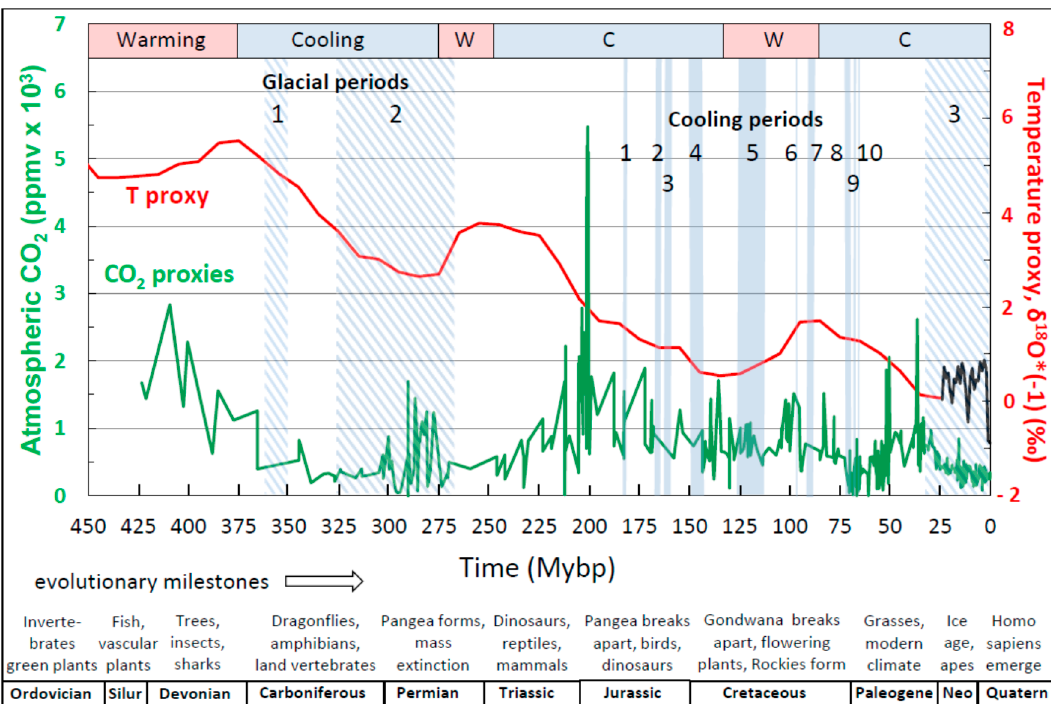
Figure 5. Temperature (T) and atmospheric carbon dioxide (CO 2 ) concentration proxies during the Phanerozoic Eon. Time series of the global temperature proxy ( δ 18 O*( − 1), red curve, n = 6680) are from Prokoph et al. [28] while concurrent atmospheric CO 2 concentration proxies (green curve, n = 831) are from Royer [40]. The red curve plots moving averages of the non-detrended T proxy averaged in 50 My windows incremented in ten-My steps (the 10–50 My moving average in Figure 3b). The green curve shows mean CO 2 concentration values in one-My bins averaged over high-resolution portions of the CO 2 record (the most recent Phanerozoic) and linearly interpolated over low-resolution portions (the older Phanerozoic). Glaciations based on independent sedimentary evidence are designated by vertical blue cross-hatched areas, while putative cool periods are designated by vertical solid blue bars. Major cooling and warming cycles are shown by the colored bars across the top while geological periods and evolutionary milestones are shown across the bottom. Abbreviations: CO 2 , atmospheric concentration of carbon dioxide based on various proxies (Methods); ppmv, parts per million by volume; Silu, Silurian; Neo, Neogene; Quatern, Quaternary. The three major glacial periods and ten cooling periods identified by blue cross-hatches and solid lines, respectively, are (after [21]): Glacial periods. 1. late Devonian/early Carboniferous; 2. Permo-Carboniferous; 3. late Cenozoic. Cooling periods. 1. late Pliensbachian; 2. Bathonian; 3. late Callovian to mid-Oxfordian; 4. Tithonian to early Berriasian; 5. Aptian; 6. mid-Cenomanian; 7. mid-Turonian; 8. Campanian-Maastrichtian boundary; 9. mid-Maastrichtian; 10. late-Maastrichtian.